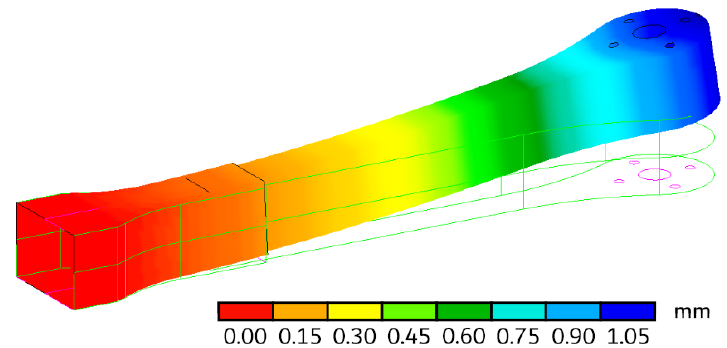
Figure 15. Transverse displacement map ( X direction), superimposed on the arm deformed shape. The results are expressed in